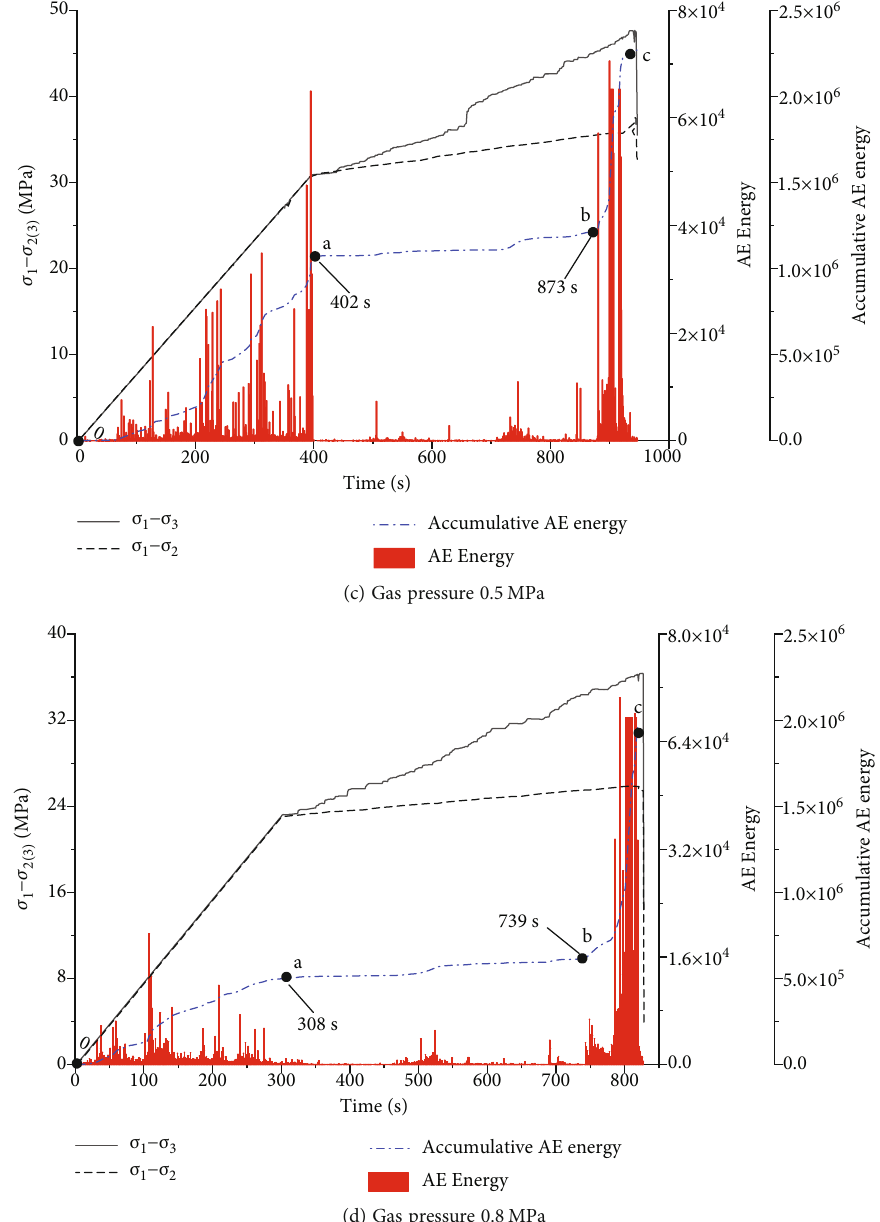
Figure 5: Time series characteristics of acoustic emission under di ff erent gas